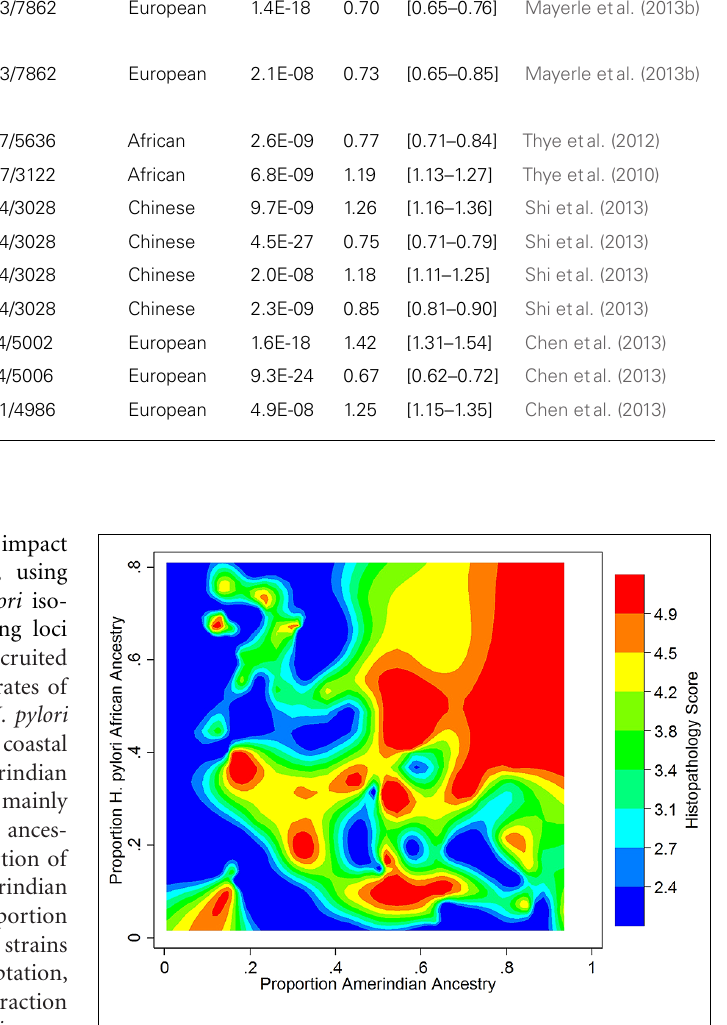
FIGURE 1 | Gastric histopathology as a function ofAmerindian human andAfrican H. pylori ancestry in a Colombian population ( N = 121, age > 39). Histopathology was scored on a continuous scale, with 2 (blue) representing gastritis and 5 (red) representing dysplasia. Data from Kodaman etal. (2014). Reference samples from the 1000 Genomes Project (Abecasis etal., 2012), HapMap (The International HapMap Consortium, 2005), and the Human Genome Diversity Project (Cavalli-Sforza, 2005) were used to calculate human ancestry, and from the MLST database (Maiden etal., 1998) to calculate H. pylori